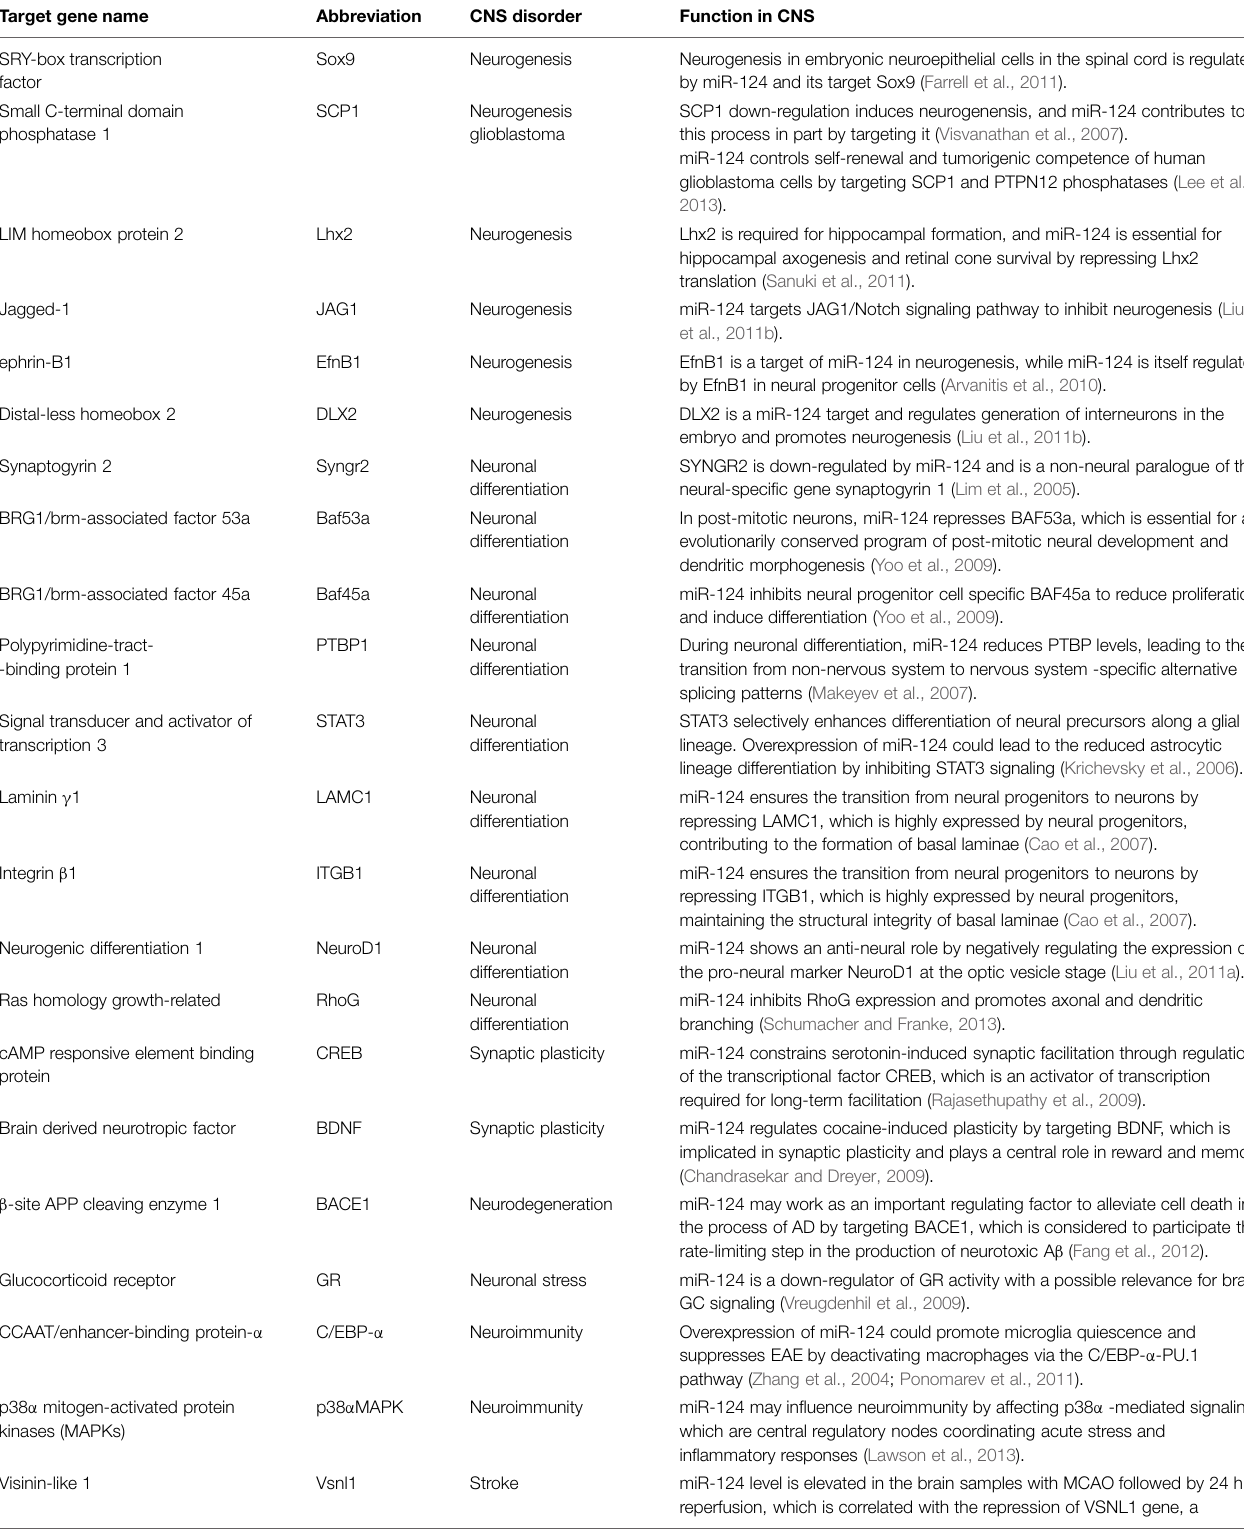
TABLE 1 | Targets of microRNA-124 (miR-124) in central nervous system